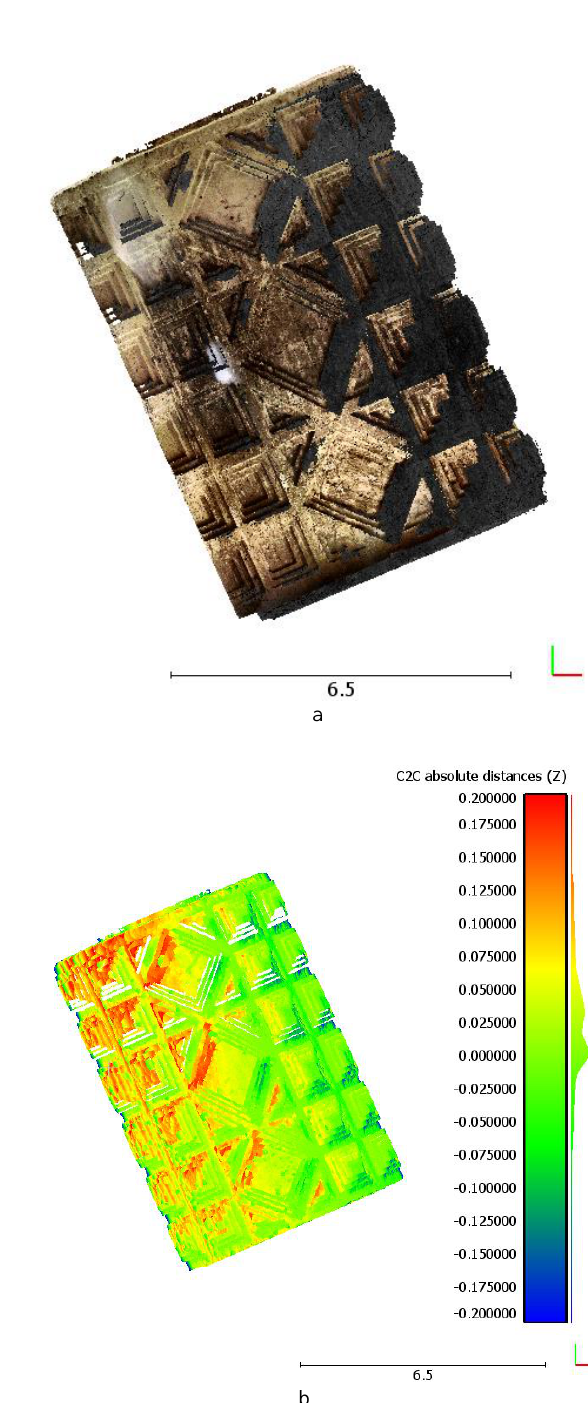
Figure 12 . Registration of the top part (a) and its distances (b) along the z axis resulting from the Cloud-to-Cloud application, registration was applied (by setting shift in the three directions x, y, z and rotation with respect to the z axis) of the two point